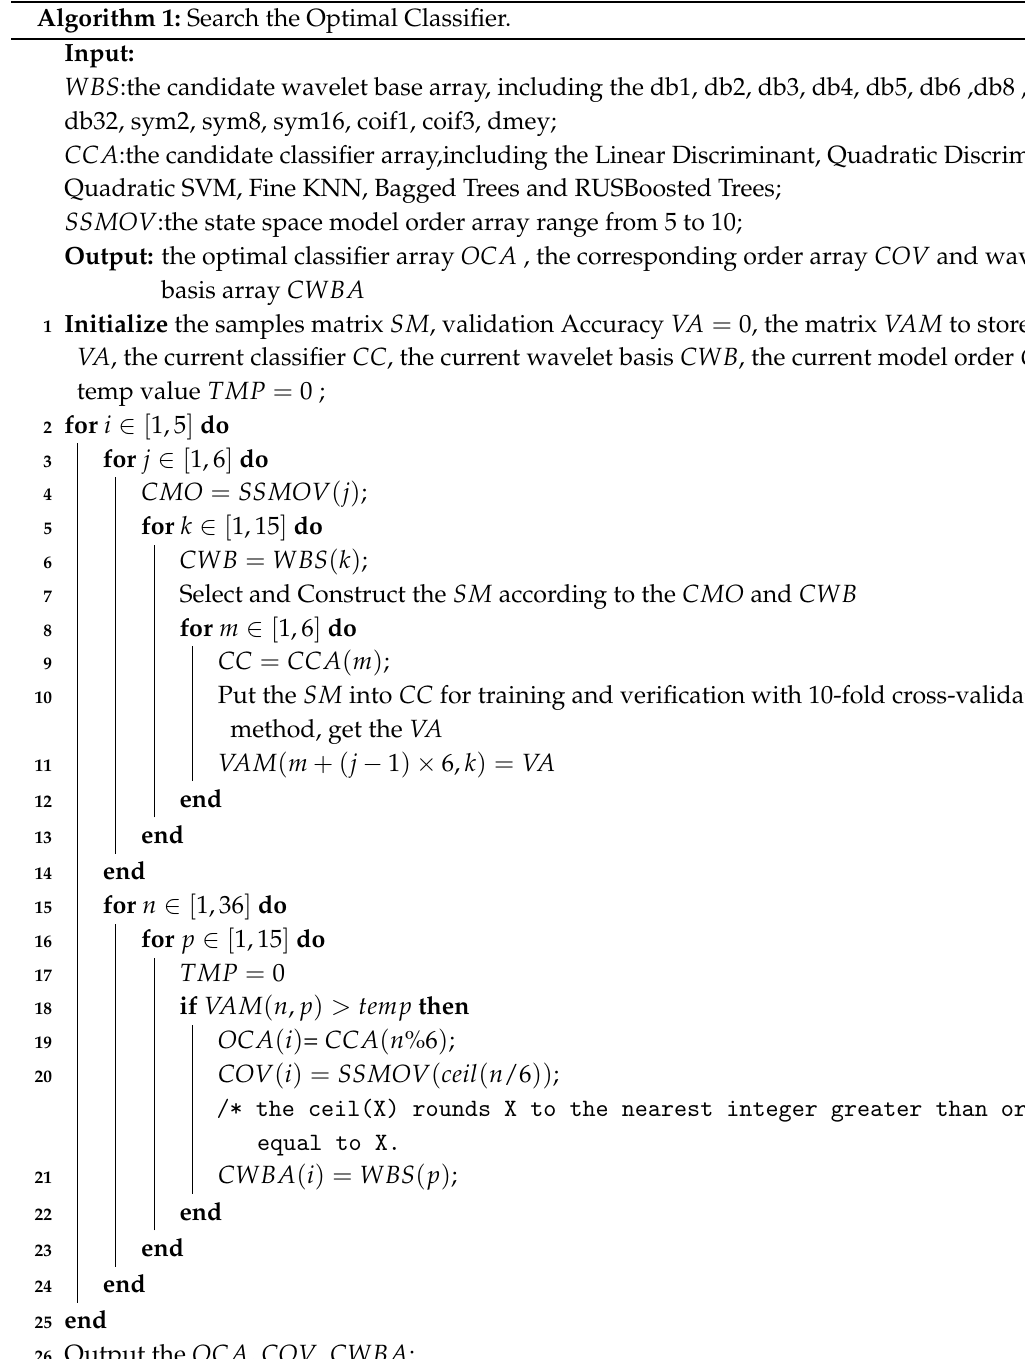
Algorithm 1: Search the Optimal Classifier.